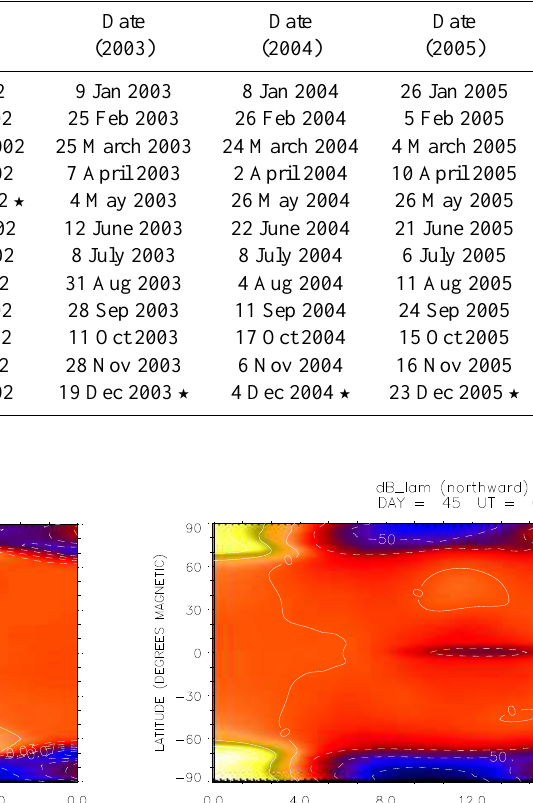
Table 1. The selected dates used in this comparison study represent the quietest day of each month from 2001–2005 as determined by the list of International Q-days. Starred dates are the quietest in a given year.